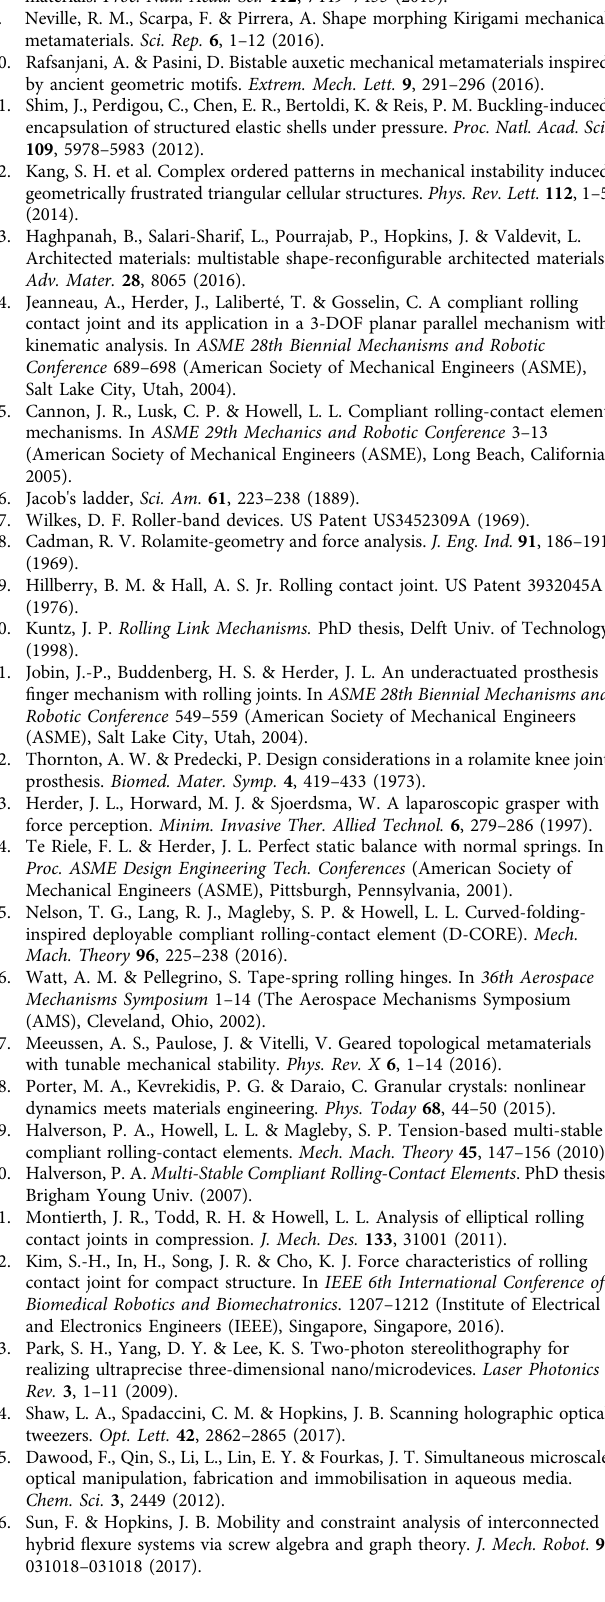
Fig. 5e. Each layer ’ s strap was fabricated slightly too short (i.e., by a length of Δ ) to fi t around the circular cams. The amount that these straps were stretched to fi t around the cams once the joint was assembled was Δ = 0.5 mm. Multiple sets of data were immediately collected after the CRJ was assembled using the test set-up of Fig. 6d for both tension and then compression loading scenarios. The results of these tests are shown in Fig. 6f, g. The measurements were averaged for each scenario and shaded error regions were calculated to de fi ne upper and lower bounds that represent two standard deviations above and below the average measurements observed. The corresponding analytical predictions and FEA results, also shown in Fig. 6f, g, were generated using the CRJ properties and parameters speci fi ed previously. We observed that, after the tension and compression tests had been conducted, the CRJ ’ s straps had all stress relaxed to the extent that their relaxed length was its original length plus Δ . Thus, when we then performed the shear test shown in Fig. 6e, we compared its results with the analytical predictions and FEA results generated using the same joint properties and parameters but with Δ = 0 mm. The angular stiffness test of Fig. 6b was the last to be conducted, so it ’ s predicted angular stiffness of zero was also calculated using Δ = 0 mm. All FEA results were generated using the auxiliary sweep feature in COMSOL using non- linear large-deformation